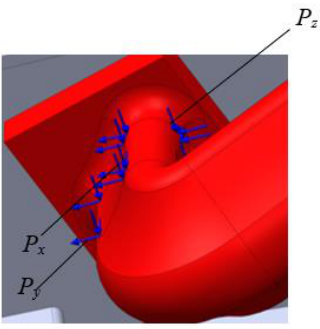
Figure 23. Scheme of applying loads to a unit for fastening.